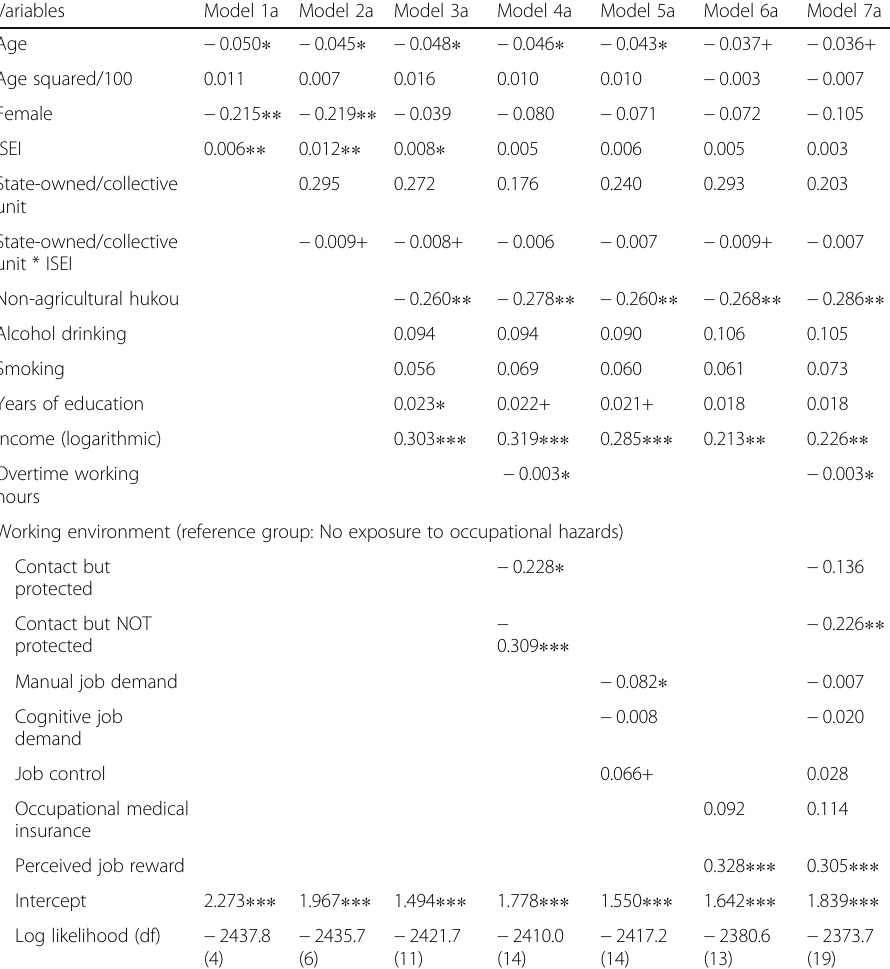
Table 4 Logit models of occupational status and working conditions on self-assessed health ( N =